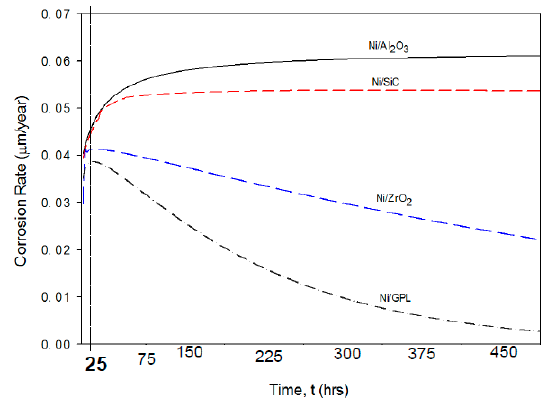
Figure 7. The predicted corrosion rates of nanocomposite coatings with respect to exposure time.